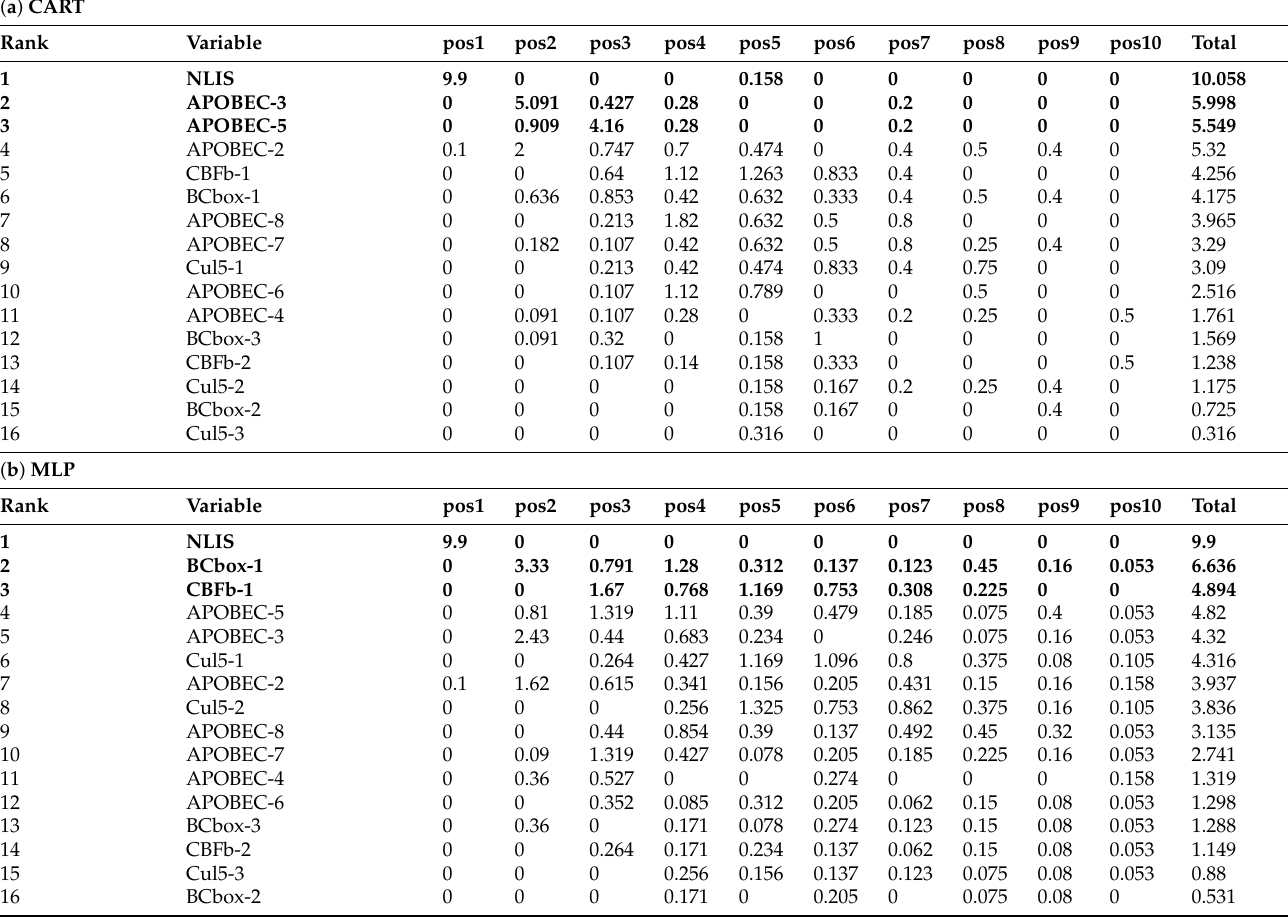
Table A4. Relevance scores ( r ) in descending order per algorithm and variable considering the clinical endpoint VLHist using the MAREV-1 approach. The three variables with higher values are highlighted in